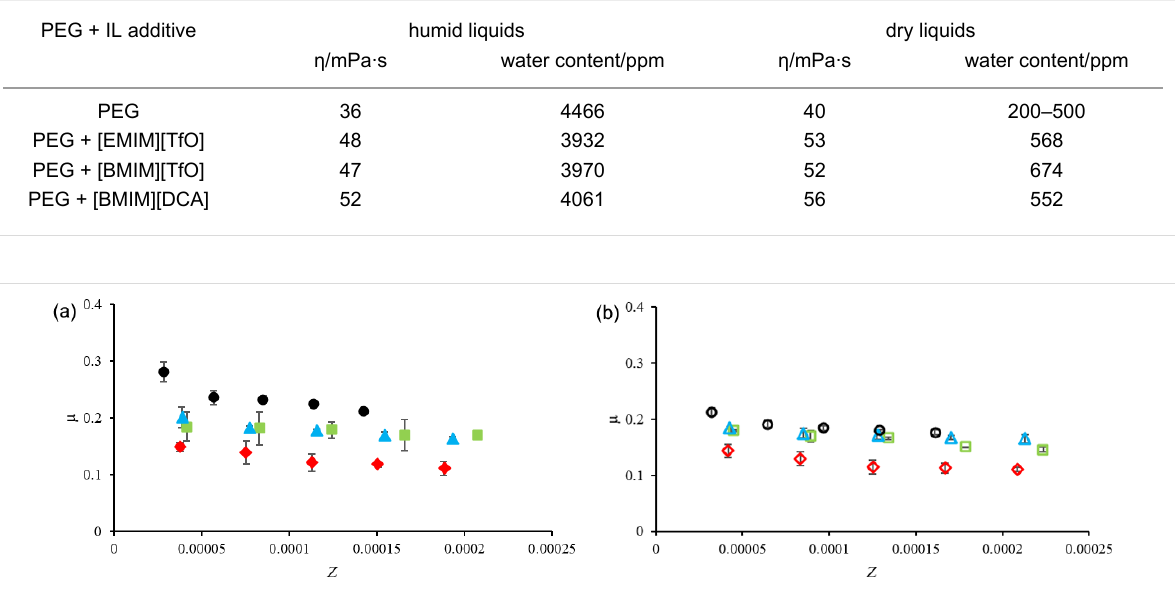
Table 1: Viscosity, η , at 25 °C and water content of dry and humid liquids.